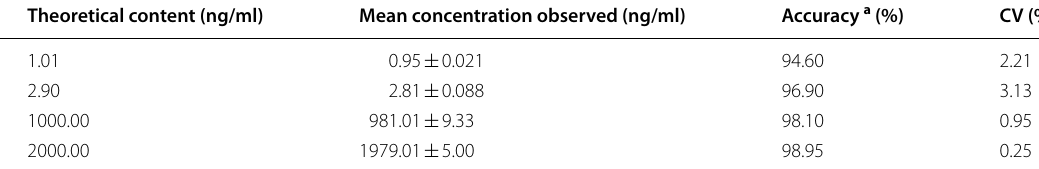
Values (Mean SD) are derived from 6 replicates: ± a Accuracy (%) Mean value of [(mean observed concentration)/(theoretical concentration)] = b Precision (%): coefficient of variance (percentage) 2.90 ng/ml; MQC: 1000 ng/ml; and HQC: 2000